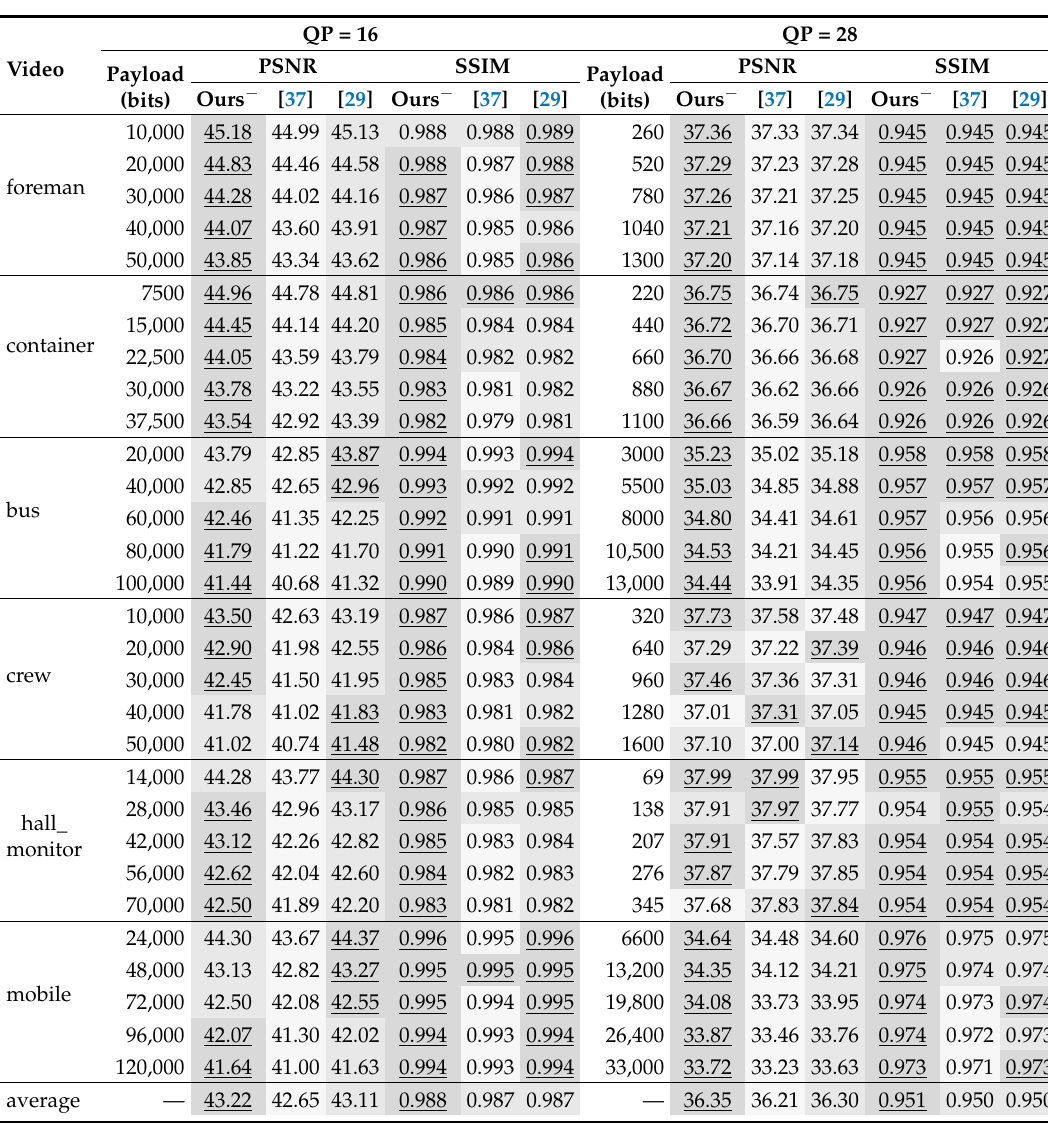
Table 6. PSNR and SSIM for different schemes without using the ( 0,0 ) coefficient pairs, where payload is the number of bits embedded into each